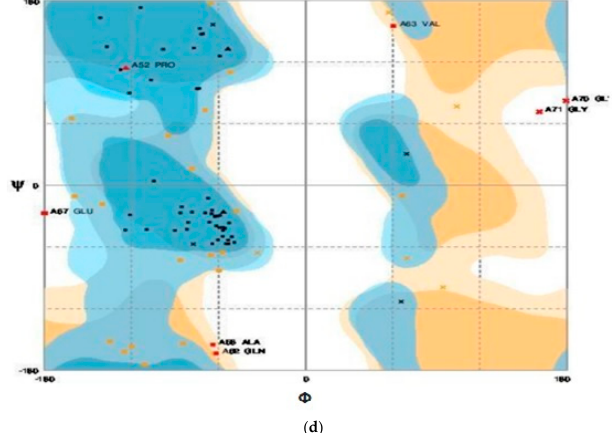
Figure 9. Ramachandran plots for ( a ) MODELLER ( 6VAM A ); ( b ) MODELLER ( 6LMT A ); ( c ) LO-ETS server; ( d ) MUSTER server.